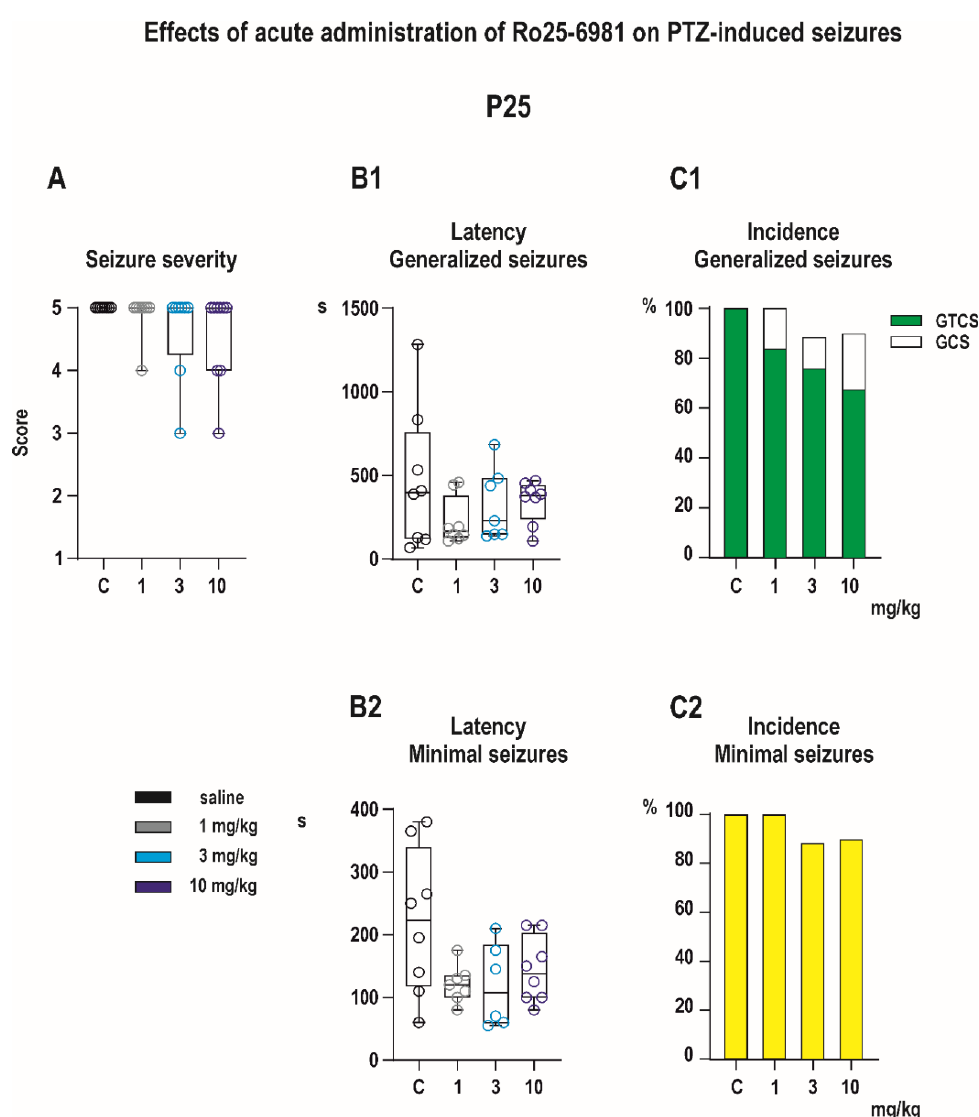
Figure 5. Effects of Ro 25-6981 on PTZ-elicited seizures in P25 pups (experimental groups consisted of 8–10 animals). None of the evaluated parameters of GS, i.e., seizure severity ( A ), latency ( B1 ), and incidence of GS or separate TF ( C1 ), was affected by administration of Ro 25-6981. Ro 25-6981 in all three doses tended to shorten latencies to minimal seizures, but differences did not reach a level of significance ( B2 ). The incidence of this seizure type remained unchanged ( C2 ). All details and symbols as in Figure